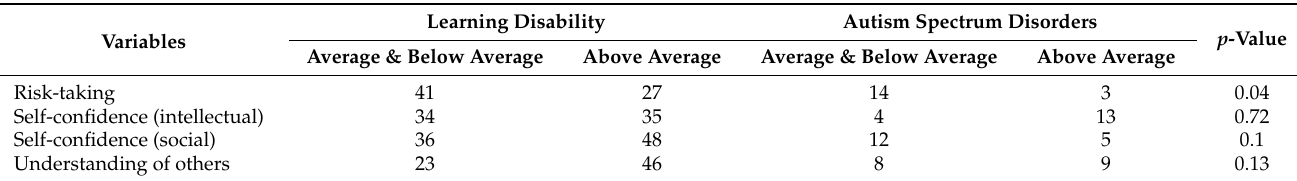
Table 2. Self-rating of students with learning disabilities and autism spectrum disorders at the end of their first-year in college